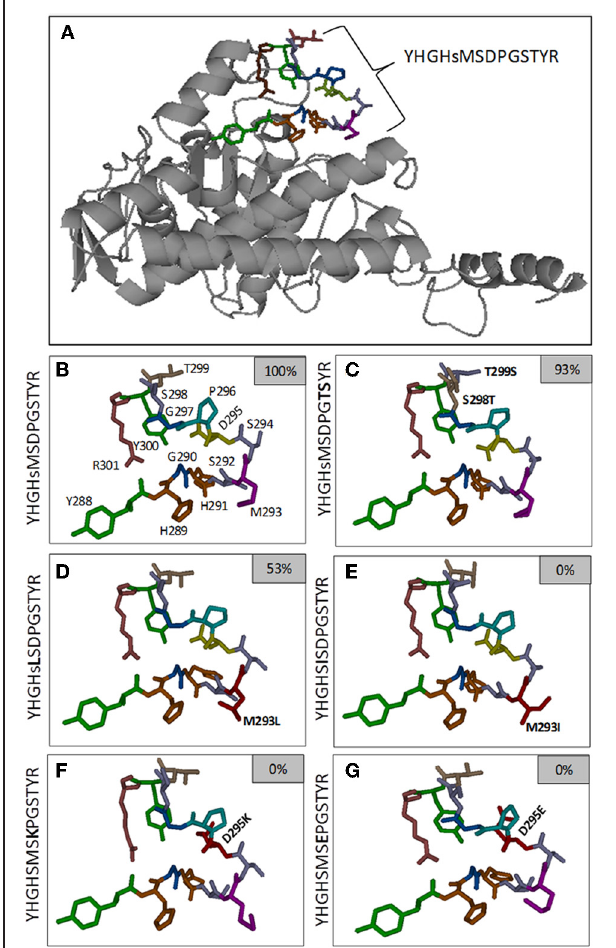
FIGURE 4 | Predicted local structure of the A. thaliana PDC E1 α subunit, with emphasis on the phosphorylation site 1 (Ser 292 )-flanking residues. Panel (A) includes the 3D representation of the full-length E1 α subunit. Regulatory phosphorylation site 1 is shown as a colored stick-diagram. In panel (B) , an enlarged version of the sequence flanking site 1 is presented. In panels (C–G) the stick-diagrams of selected amino acid substitution variants are presented. The small inset boxes indicate the extent of phosphorylation relative to the native